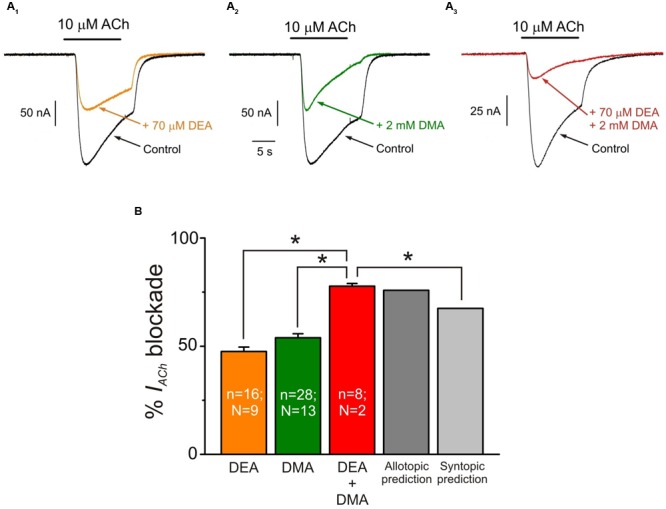
Additive inhibitory effects of DMA and DEA on IACh. (A1–A3) Representative IACh recordings obtained when superfusing the oocyte with 10 μM ACh either alone (A1–A3; Control, black) or co-applied with 70 μM DEA (A1; + 70 μM DEA, orange), 2 mM DMA (A2; + 2 mM DMA, green) or 70 μM DEA plus 2 mM DMA (A3; + 70 μM DEA + 2 mM DMA, red). (B) Column graph showing the average IACh inhibition elicited by co-application of 10 μM ACh with the different combinations showed in (A) as indicated below each column. The two right most columns show the values predicted by the allotopic and syntopic models of interaction (see text for details). The asterisks above the bars indicate significant differences between groups (p < 0.05, t-test; comparisons of DEA + DMA values with those estimated by each model of inhibition were carried out with one-sample t-test).